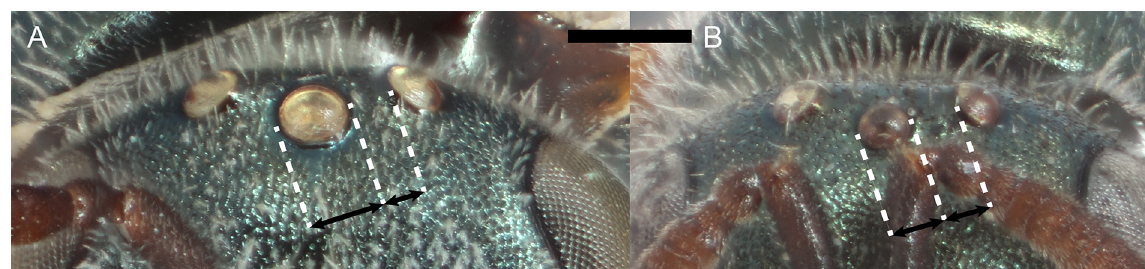
Fig. 103. Ocelli. A . Lasioglossum ( D. ) eophilus (Ellis, 1914), ♀, slightly enlarged and separated by less than two thirds of one ocellar diameter. B . L. ( D. ) miltolepoides sp. nov., ♀, normal size, separated by more than two thirds of one ocellar diameter. Scale bar: 0.25 mm.